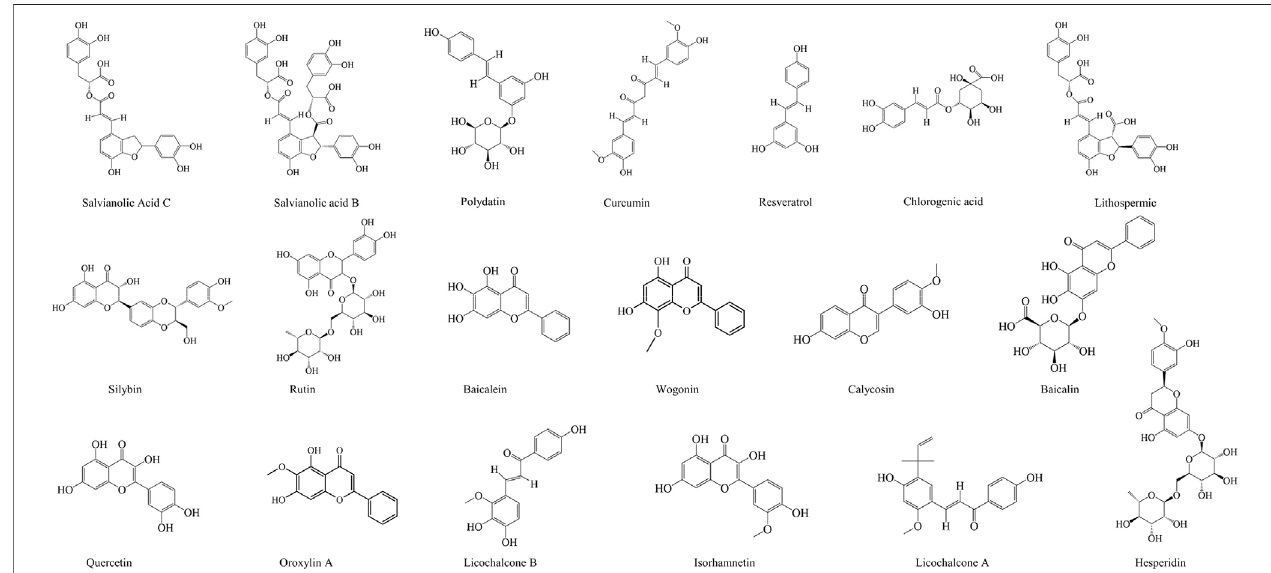
FIGURE 6 | The chemical structures of phenols and fl avonoids showing anti-hepatopathy